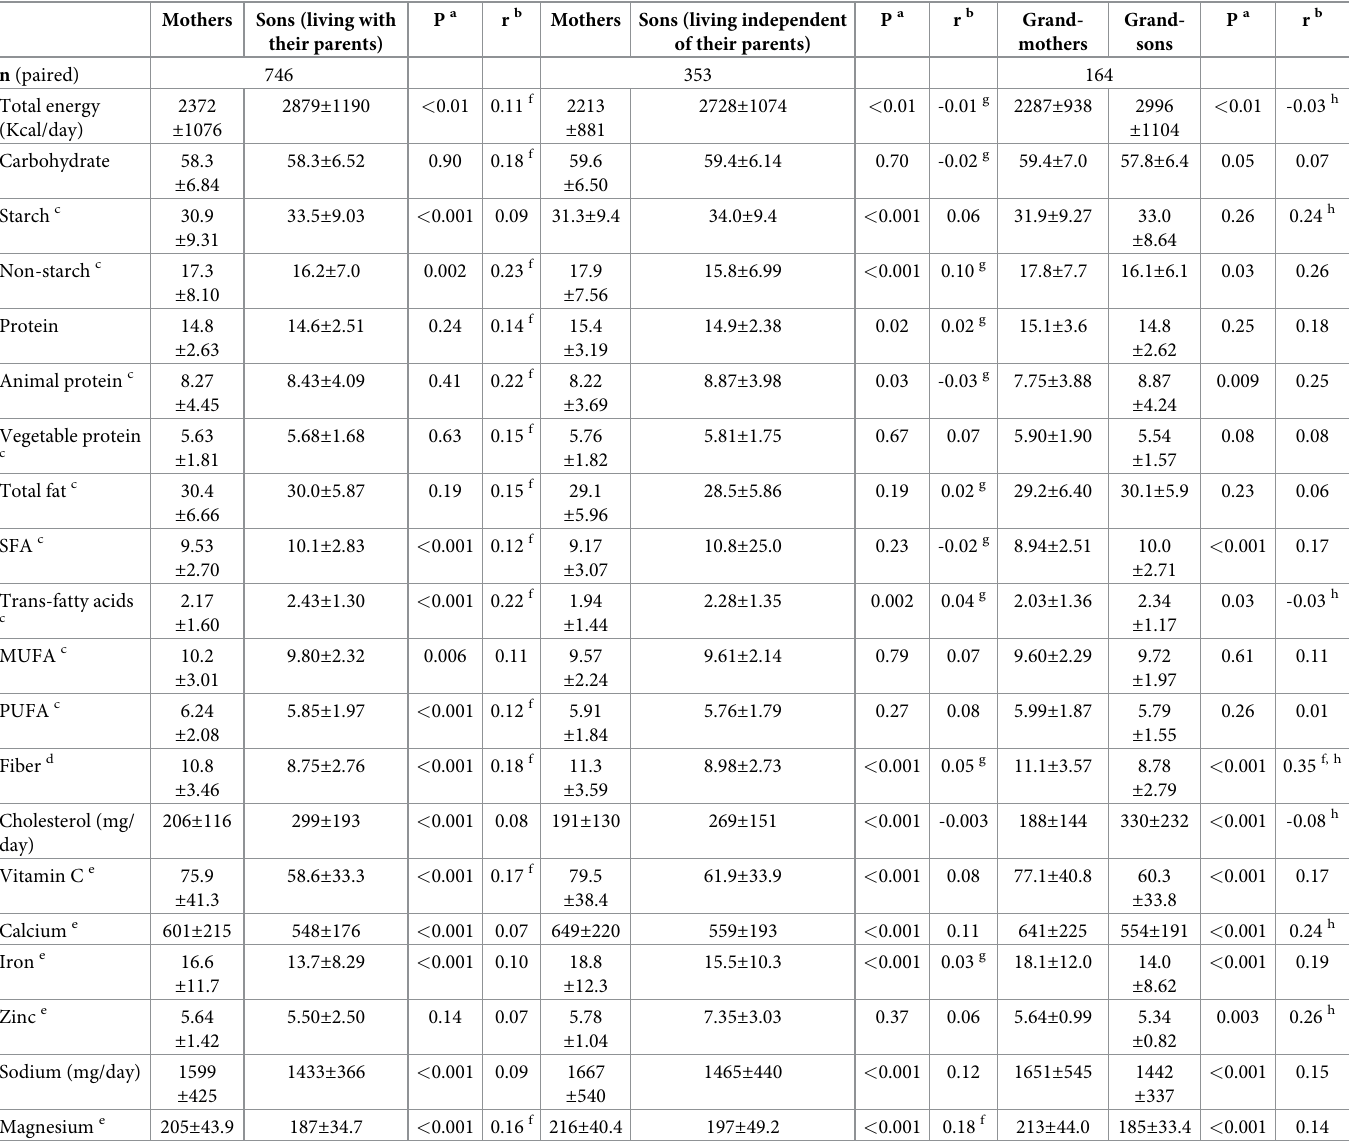
Table 4. Total energy and nutrient intakes of 3 generations of participants (mothers-sons) by living status. Mothers Sons (living with their